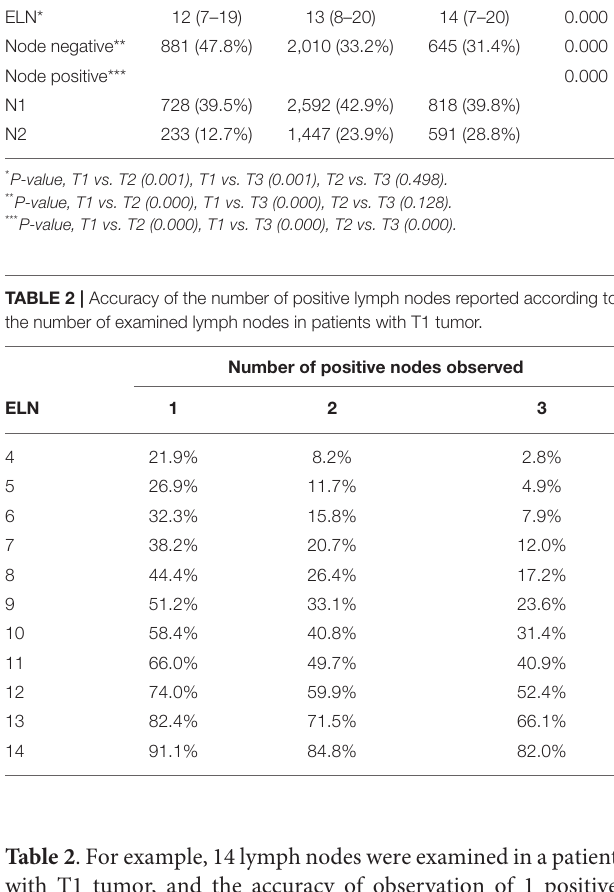
TABLE 3 | Accuracy of the number of positive lymph nodes reported according to the number of examined lymph nodes in patients with T2 tumor. Number of positive nodes observed